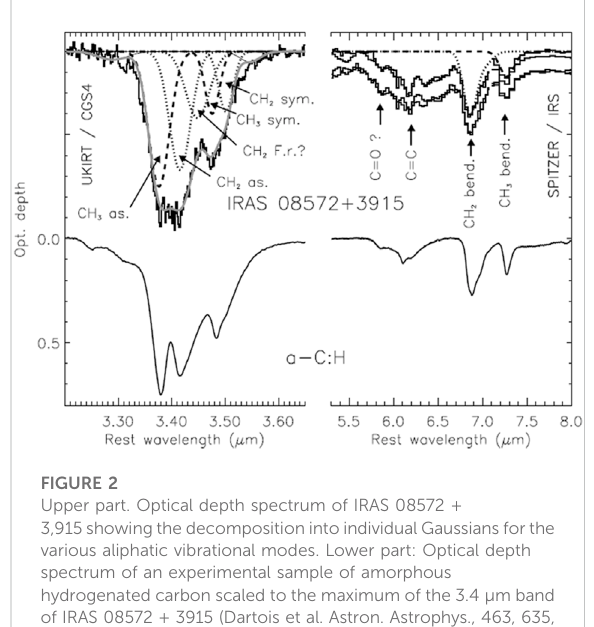
FIGURE 2 Upper part. Optical depth spectrum of IRAS 08572 + 3,915 showingthe decomposition into individual Gaussians for the various aliphatic vibrational modes. Lower part: Optical depth spectrum of an experimental sample of amorphous hydrogenated carbon scaled to the maximum of the 3.4 μ m band of IRAS 08572 + 3915 (Dartois et al. Astron. Astrophys., 463, 635, 2007, reproduced with permission © ESO).